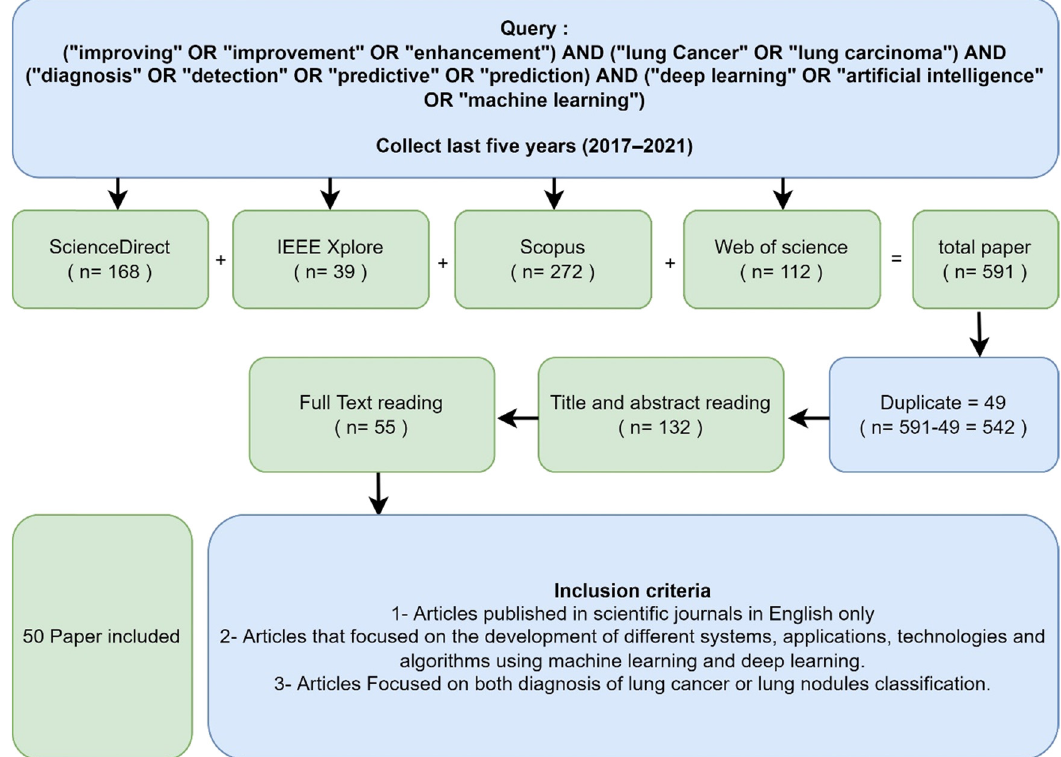
Figure 2: Study selection fl owchart with exact query and inclusion